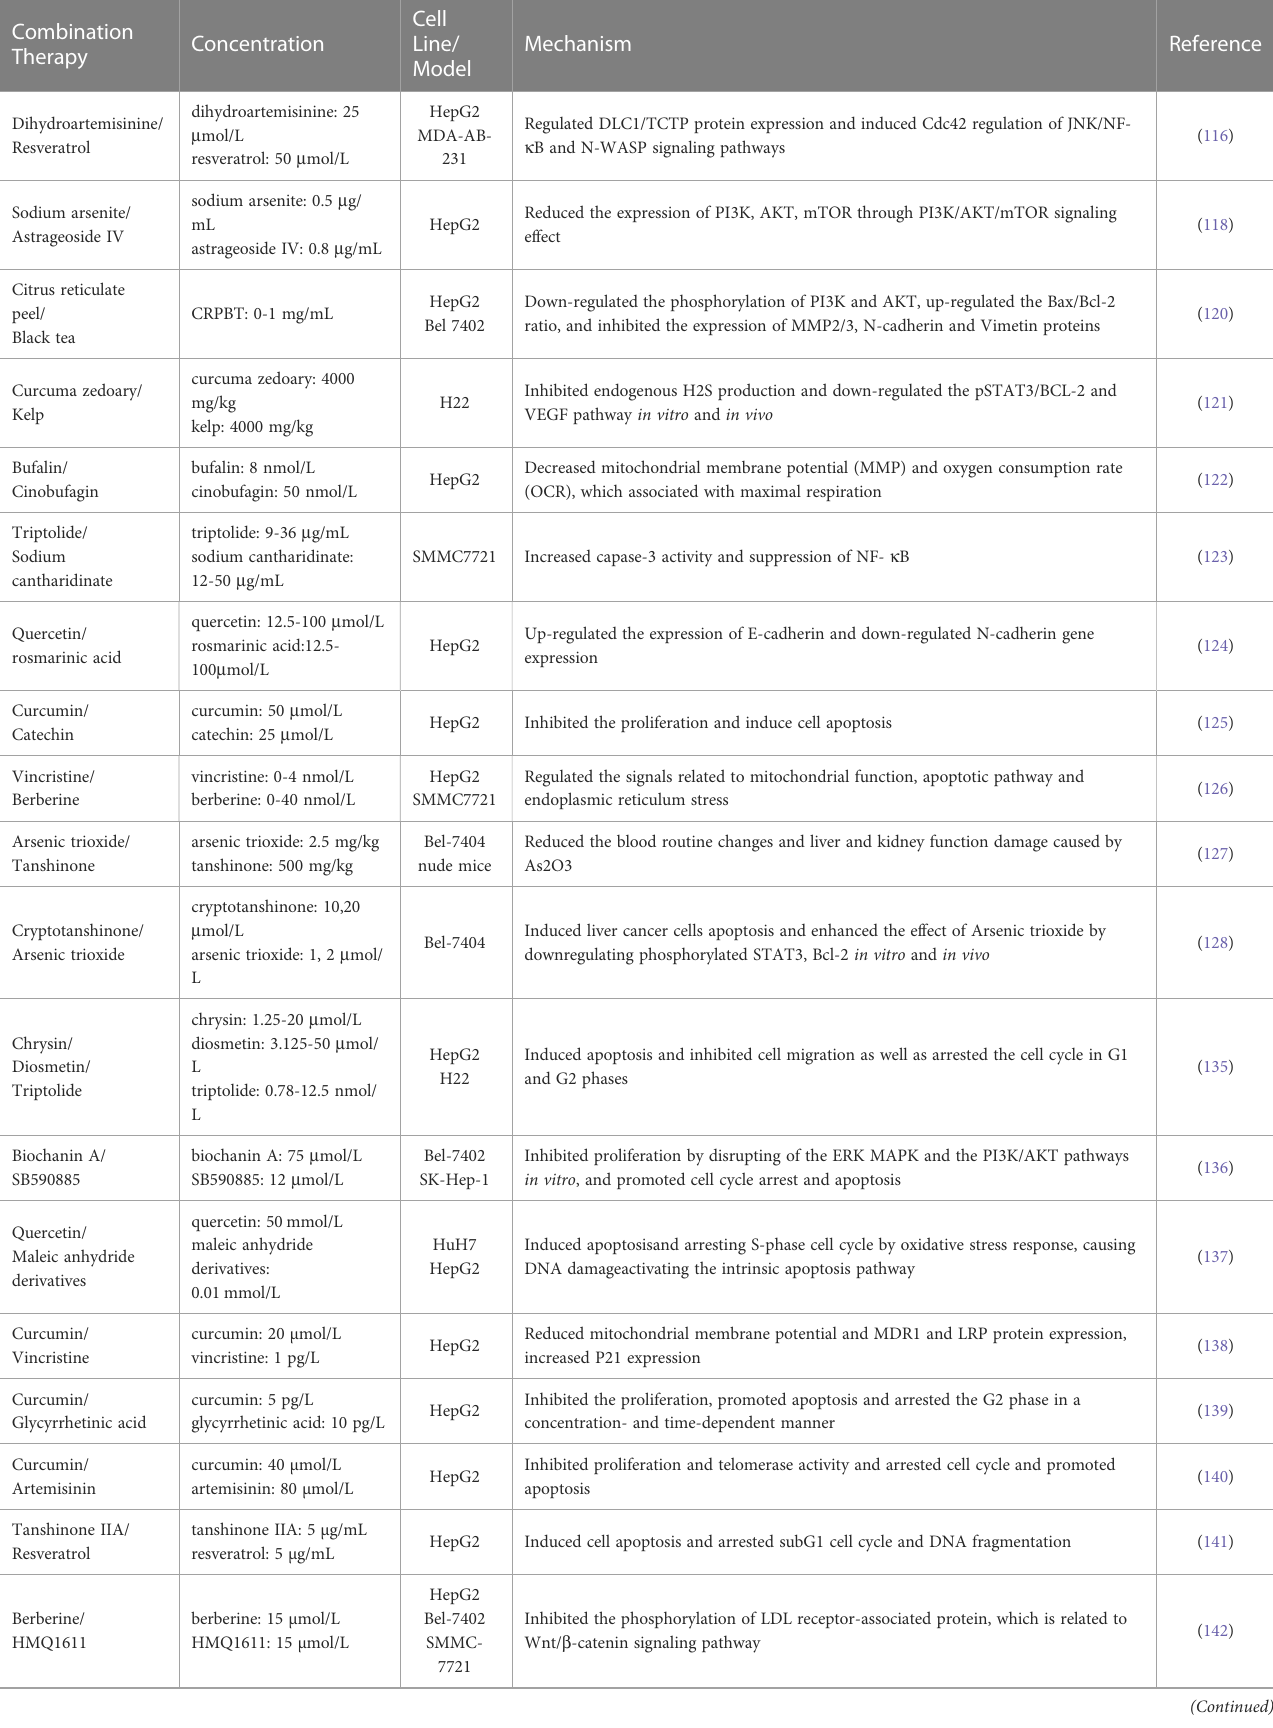
TABLE 1 Effect and mechanism by combination of plant-derived natural product ingredients on liver cancer. Combination